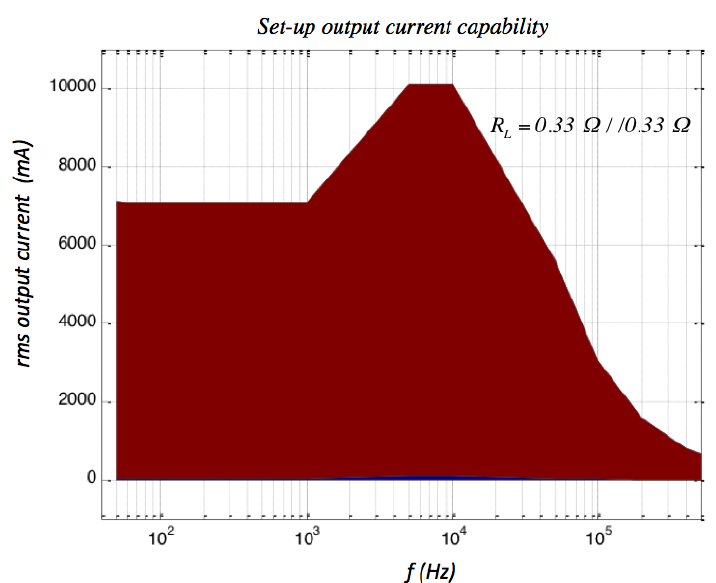
Figure 8. High-frequency set-up output current capability.